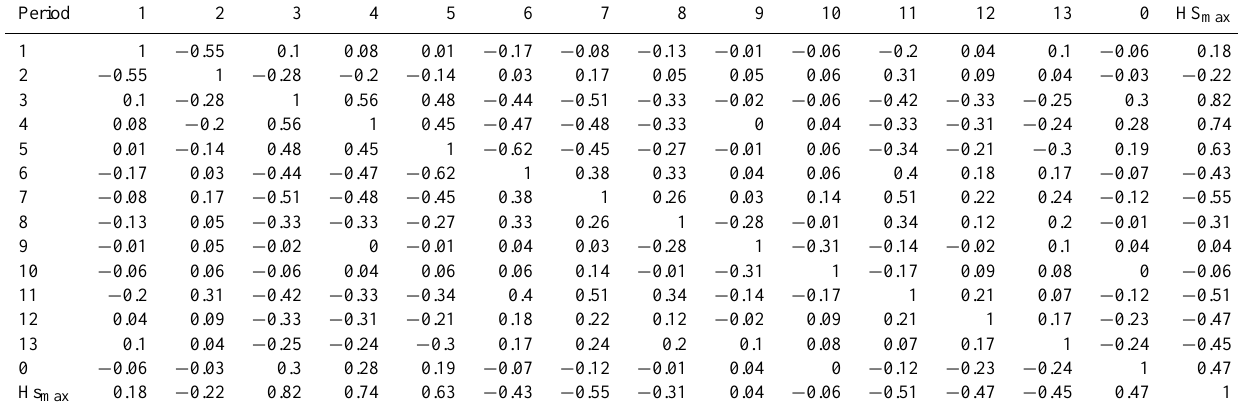
Table 5. Persons Correlation coefficients between distributions of snow depth change (dHS) and snow depth at the end of the accumulation season (HS max ) in the rock face Ch¨upfenflue on different days in 2009. Periods are described in Table